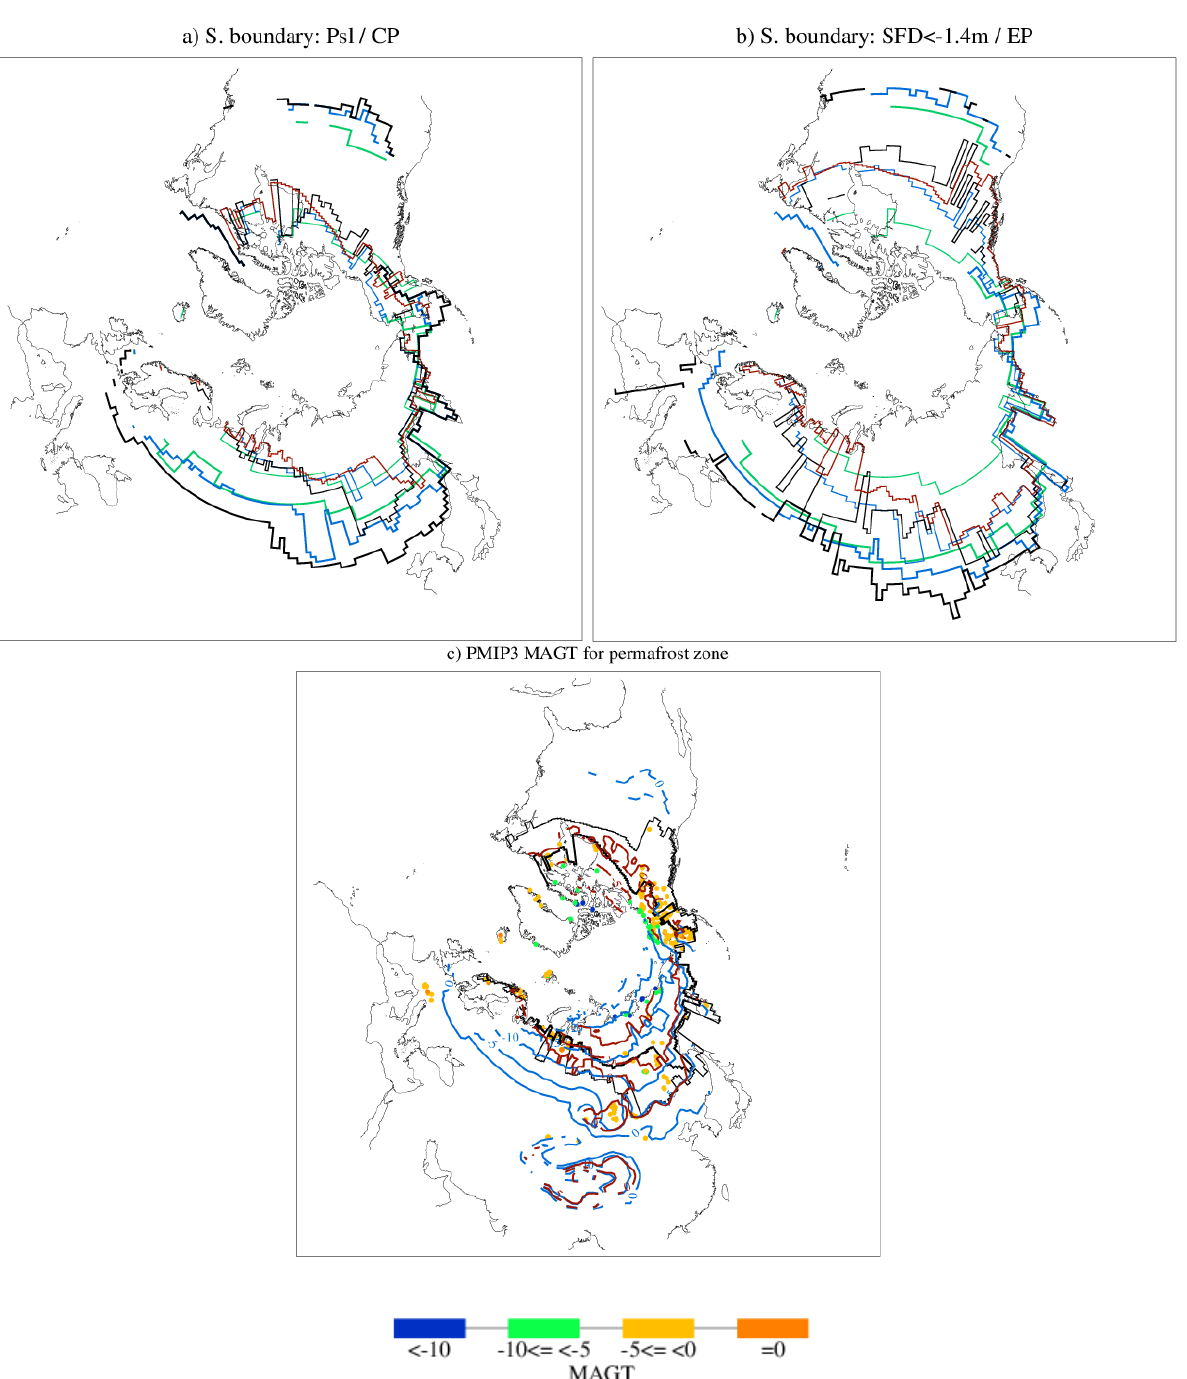
Fig. 5. (a) Southern boundary of the latitudinal permafrost zones in the Northern Hemisphere for continuous permafrost for pre-industrial (0kya; thin lines) and LGM (21kya; thick lines) periods, as defined in Fig. 2a and b, respectively. The boundaries for the T as -based diagnosis (CP) are shown in color (blue for PMIP3 and green for PMIP2), while those for the T sl -based diagnosis ( P sl ) are shown in black. Observed boundaries for the present-day continuous permafrost are shown by red lines. (b) represents the southern boundary of overall permafrost for 0kya (thin lines) and 21kya (thick lines). The boundaries for the T as -based diagnosis (colored) are taken as environmentally conditional (EP), while T sl -based boundaries (black) are defined by areas with seasonal frost depth of less than 1.4m. (c) is the multi-model median of mean annual ground temperature (MAGT) for the pre-industrial (red) and LGM (blue) periods. Contour interval is 5 ◦ C. Only temperatures below 0 ◦ C on the exposed land areas are shown. The observed boundaries for the present day are reproduced from (a) and (b) in black thick and thin lines, respectively. Observed MAGT by IPY-TSP are shown by closed circles.